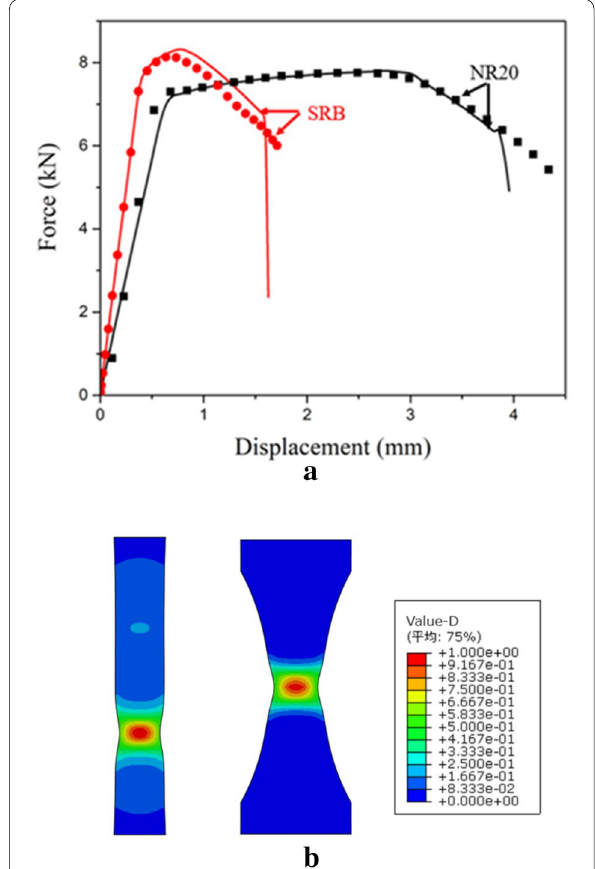
Figure 17 Application of the MMC model: a experimental and computational force–displacement responses and b field of damage